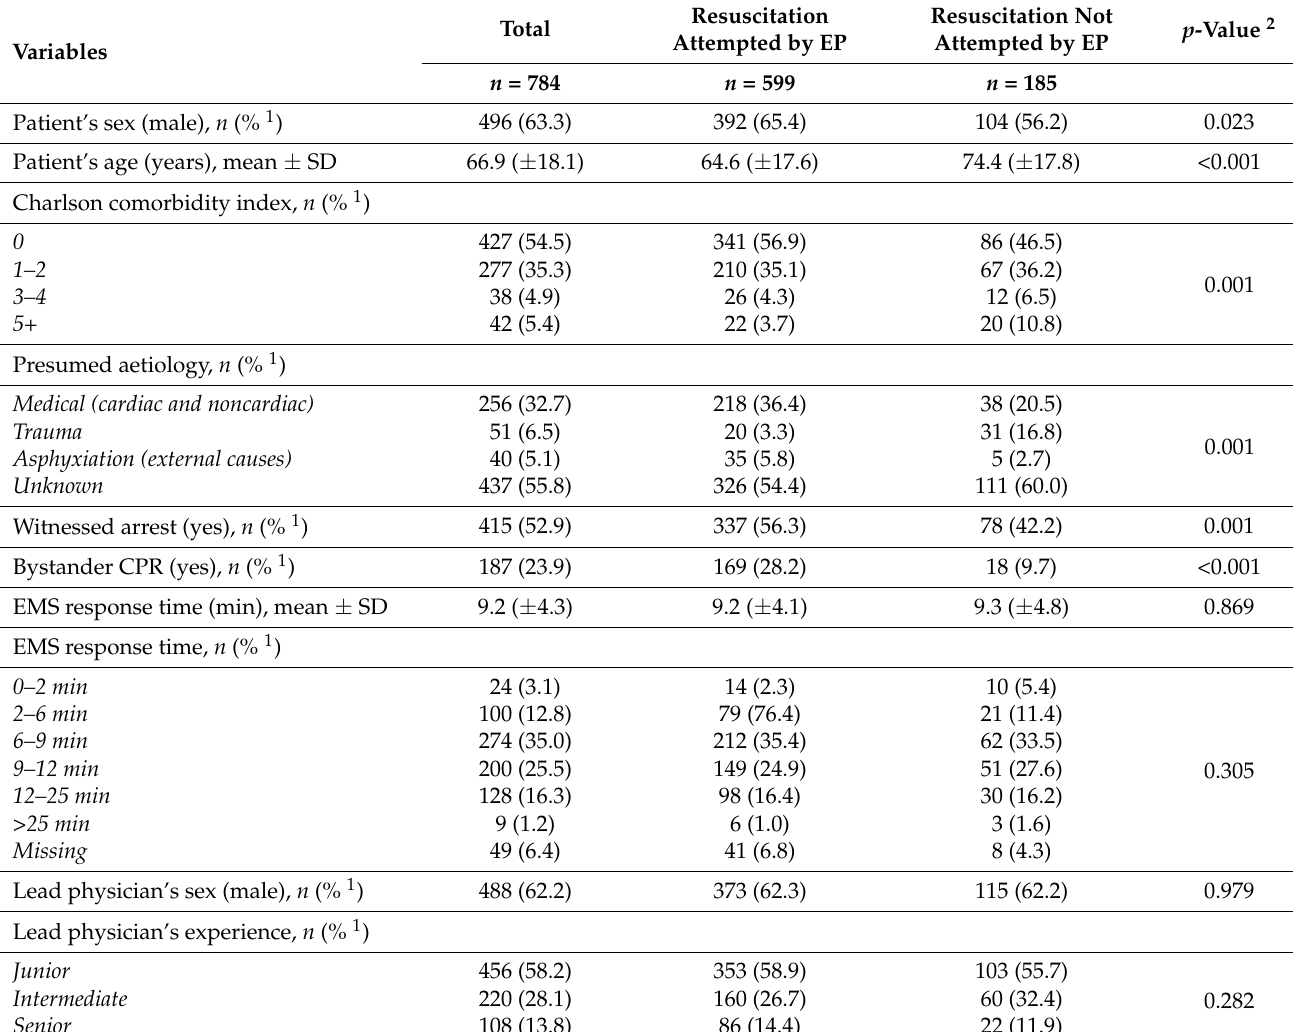
Table 1. Patient